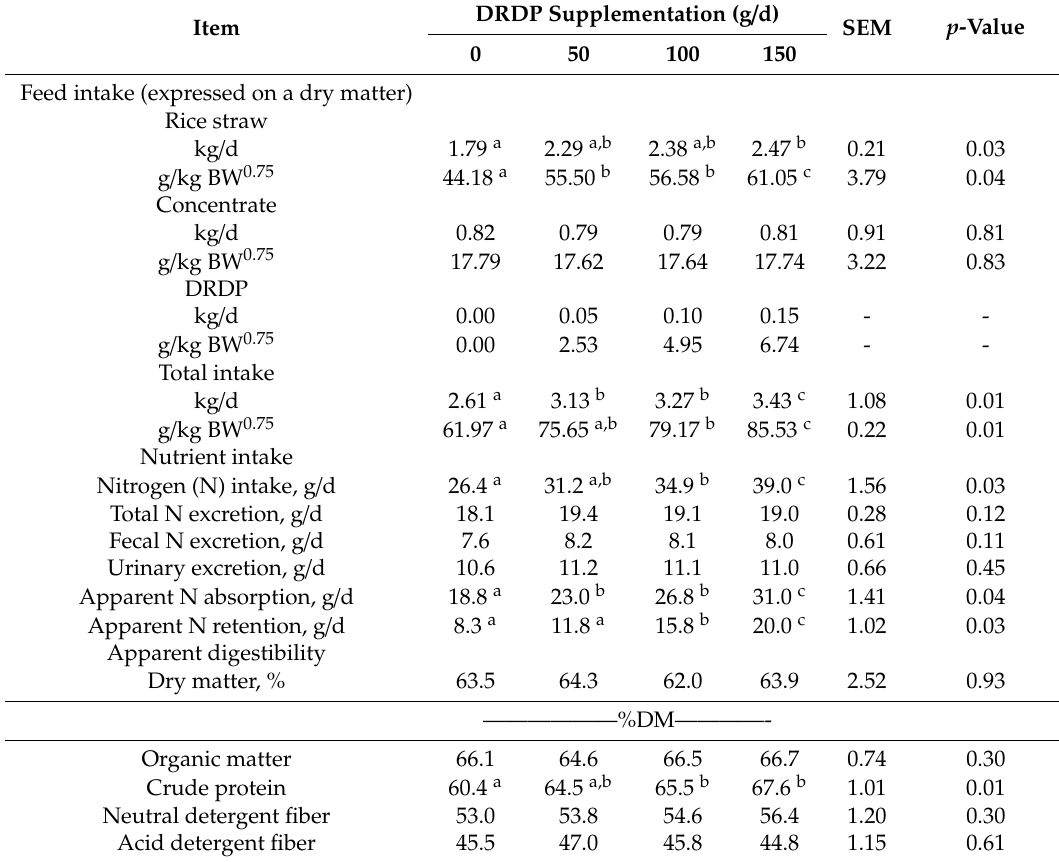
Table 2. E ff ect of dried rumen digesta pellets (DRDP) on feed intakes and apparent digestibility in Thai native, Wagyu-crossbred beef cattle.